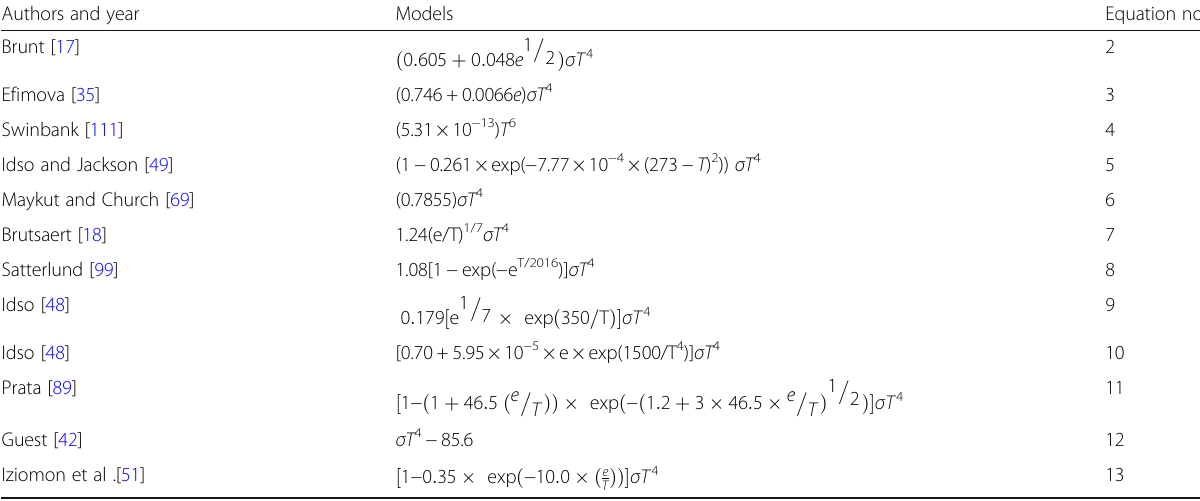
Table 1 Some of the uniquely different cloudless DLR regression models considered in this study Authors and year